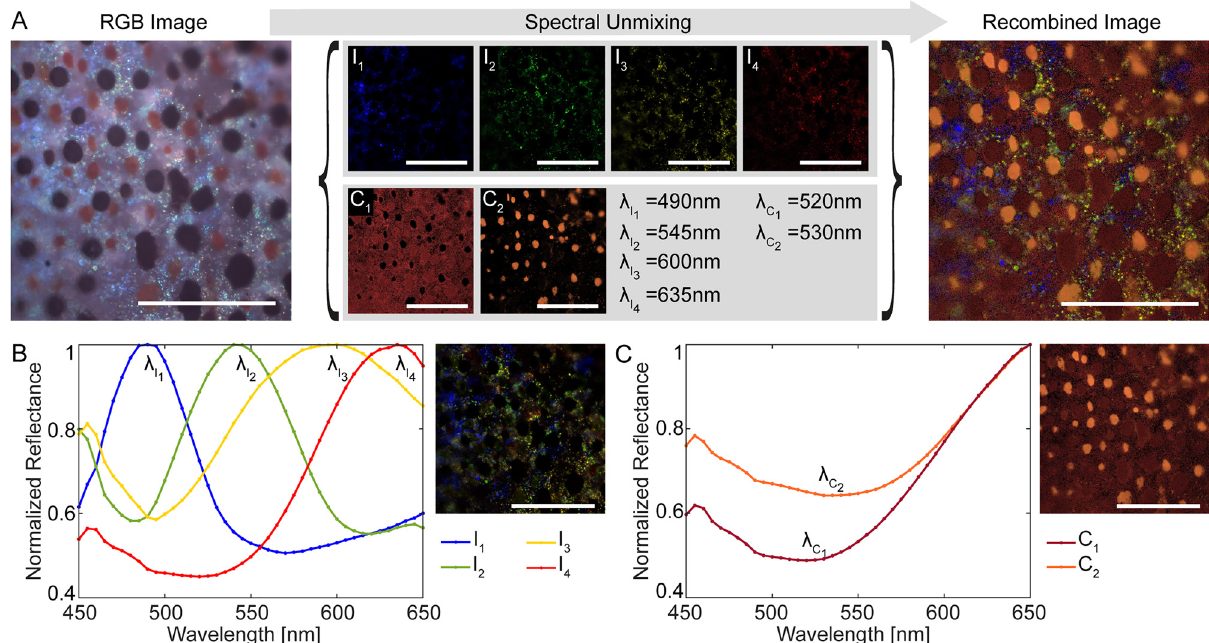
Figure 2: Multispectral map of freshly excised, stabilized octopus ’ skin. (A) The RGB image of freshly excised stabilized Octopus bimaculoides skin is spectrally unmixed in false-color images that show the spatial distribution of the iridophores (Spectral Unmixing I 1 – I 4 ) and of the chromatophores (Spectral Unmixing C 1 – C 2 ) in the spectral range 450 – 650nm.Therecombinationoftheindividualspectralbandsgeneratesafalse-colorcompositeimageshowingthechromaticelements ’ spatial distribution (Recombined Image). The iridophores ’ spectral response is identi fi ed by their re fl ectance maximum ( λ I1 – λ I4 ), while the chromatophores ’ by their re fl ectance minimum ( λ C1 – λ C2 ). (B) Corresponding normalized re fl ectance spectra of the iridophores ( I 1 – I 4 ) and combined multispectral map of the iridophores only (top right panel). (C) Corresponding normalized re fl ectance spectra of the chromatophores ( C 1 – C 2 ) and combined multispectral map of the chromatophores only (top right panel). Scale bar: 200